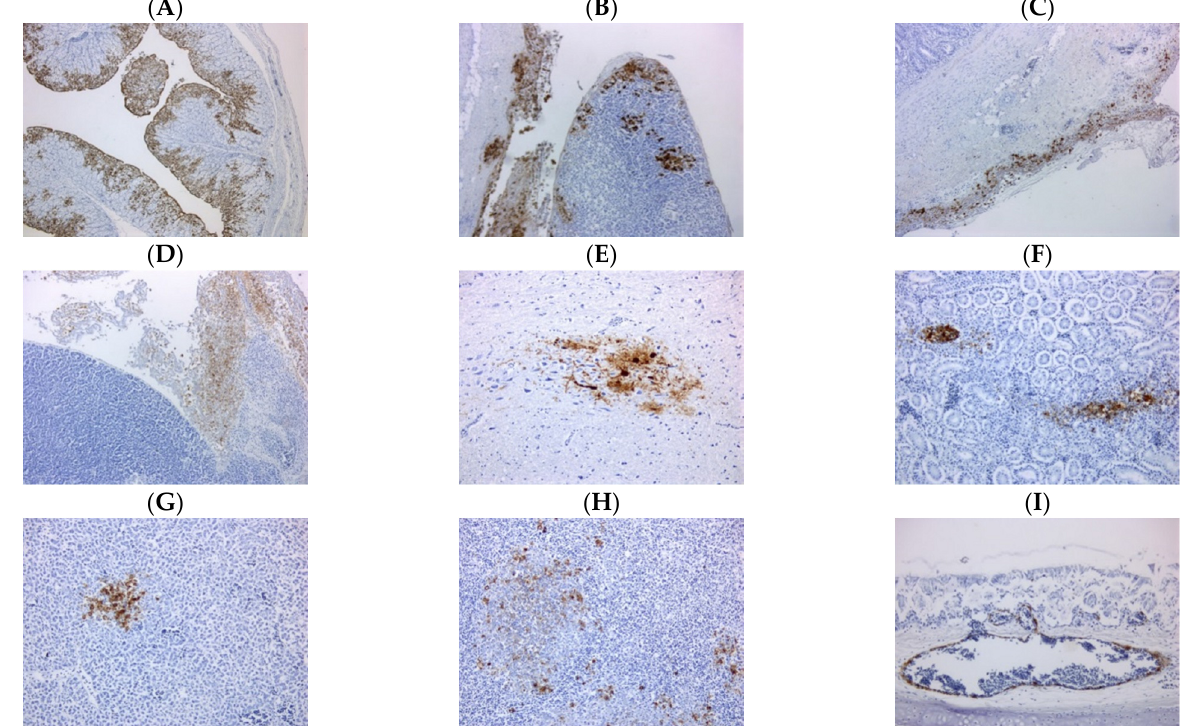
Figure 2. Immunohistochemistry (IHC) revealed systemic dissemination of influenza A viral antigen. Representative IHC images of tissue sections labelled against influenza A viral antigen (brown) taken from ( A ) oviduct, ( B ) pancreas and peritoneum, ( C ) jejunal peritoneum, ( D ) pancreatic surface, ( E ) brain, ( F ) kidney, ( G ) liver, ( H ) spleen and ( I ) tracheal vascular endothelium. The following magnifications were used: images ( A , B ) 50×, images ( C , D ) 100× and images ( E – I ) 200×.